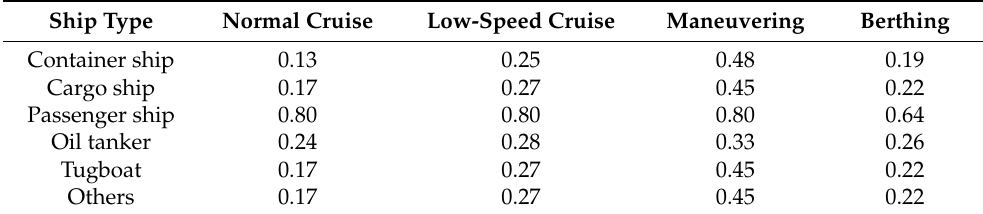
Table 7. Load ratio coefficient of auxiliary engines of various ship